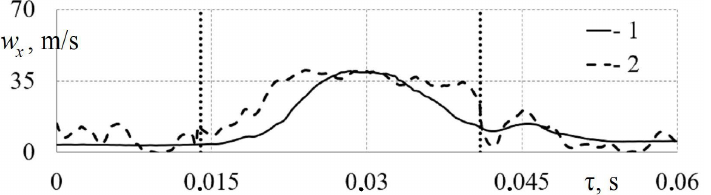
Figure 7. Dependences of the local ( l x = 100 mm) air flow velocity w x in the intake systems of the engine laboratory model (1) and gasoline RICE (2) on time τ for a crankshaft speed of 1800 rpm and for d = 32 mm. The vertical lines indicate the opening and closing times of the intake valve.